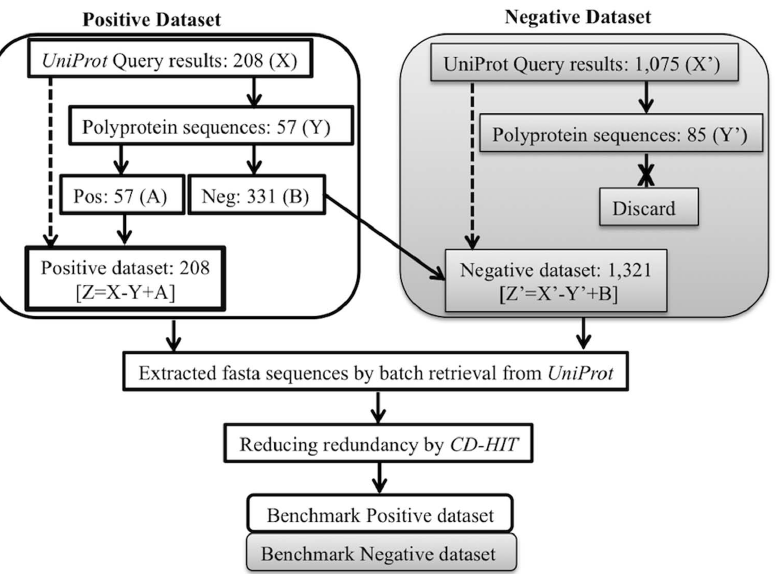
Figure 2. Schematic representation of the dataset generation and filtration steps. The figure shows flowchart for the steps followed for sequence collection, filtering and redundancy removal for training dataset generation.